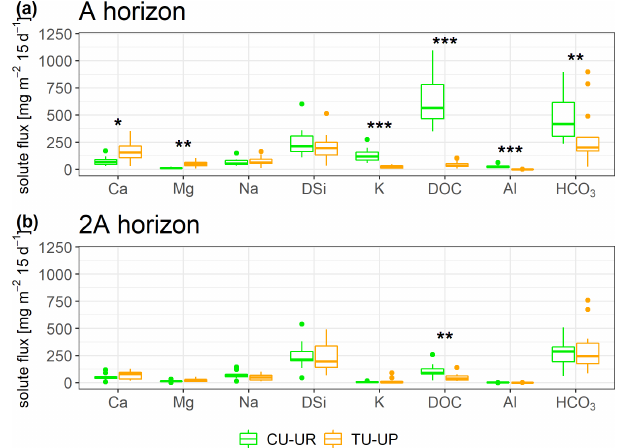
Figure 9. Biweekly solute fluxes in the two upper horizons of the CU-UR and TU-UP profiles. The Mann–Whitney U test was ap- plied for differences between vegetation types, with levels of sig- nificance ∗ , ∗∗ , and ∗∗∗ corresponding to p< 0 . 05, p< 0 . 01, and p< 0 .